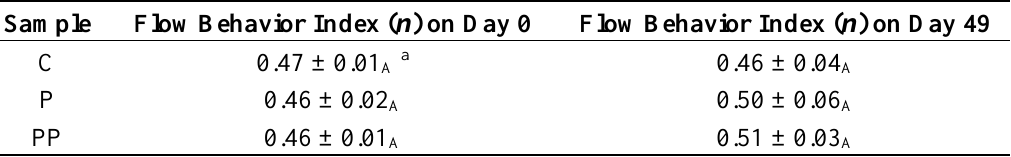
Table 3. The changes of the flow index behavior (n) of oatmeal-coconut water matrix during the shelf